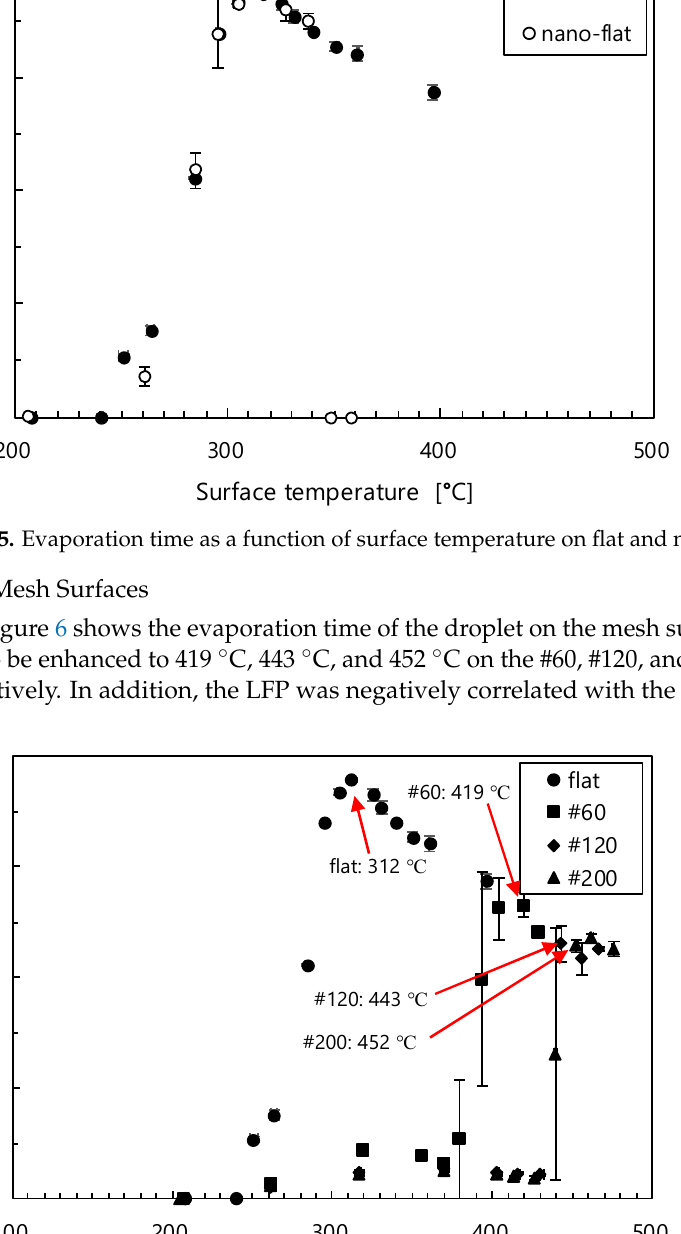
Figure 6. Evaporation time as a function of surface temperature on flat and mesh surfaces.